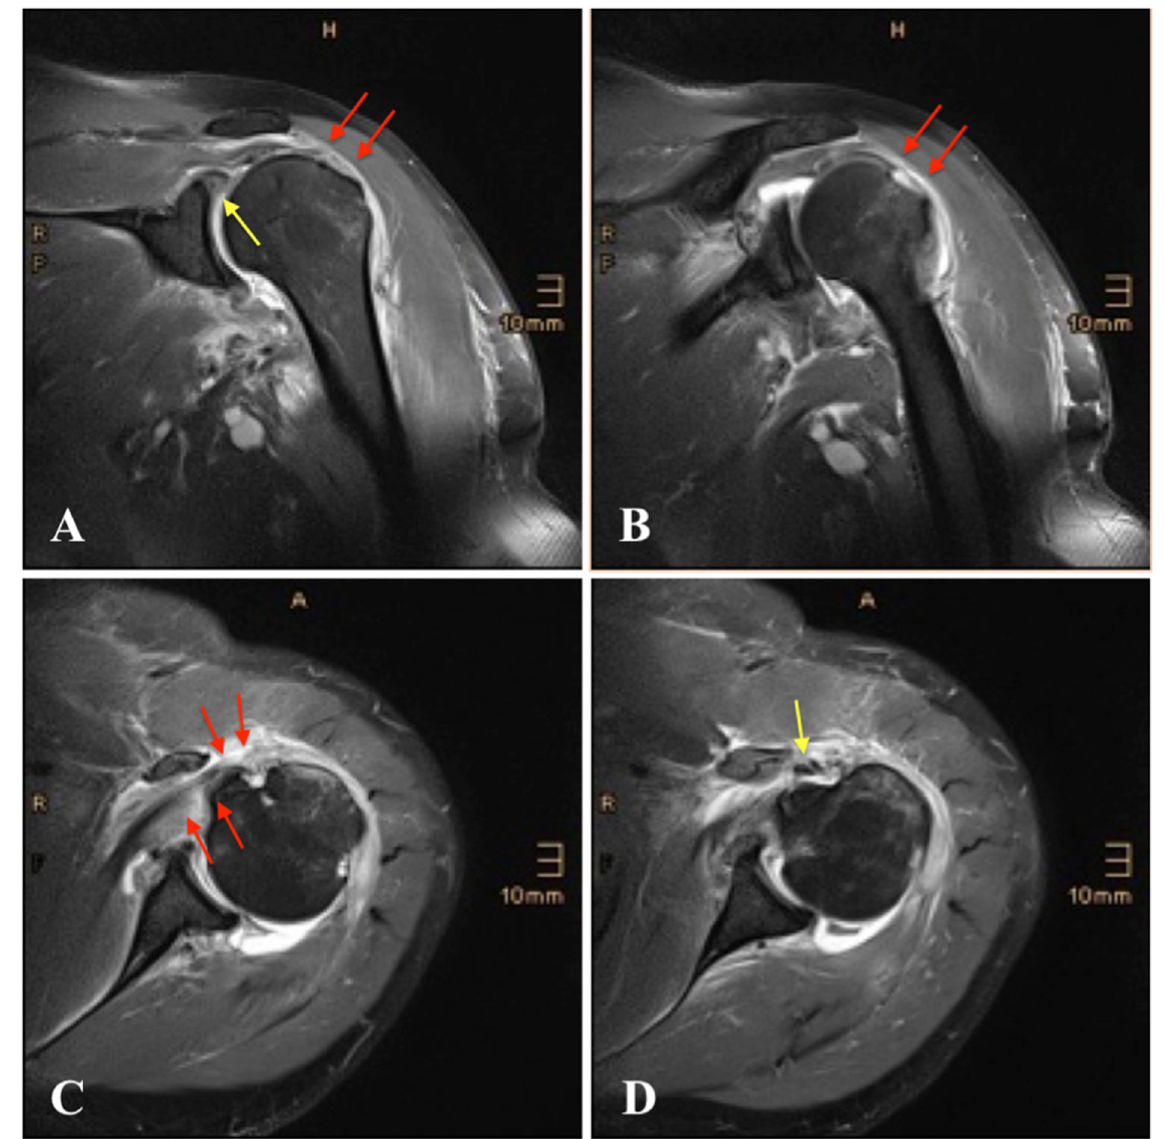
Figure 4. Magnetic resonance imaging (MRI) of the left shoulder following inferior dislocation: ( A ), coronal view with tear of the supraspinatus tendon (red arrows) and superior labrum anterior and posterior (SLAP) lesion (yellow arrow); ( B ), coronal view with tear of the infraspinatus tendon (red arrows); ( C ), axial view with tear of the subscapularis tendon and fatty degeneration of the muscle (red arrows); ( D ), axial view with rupture of the long head of the biceps tendon (LHBT) (yellow arrow) .